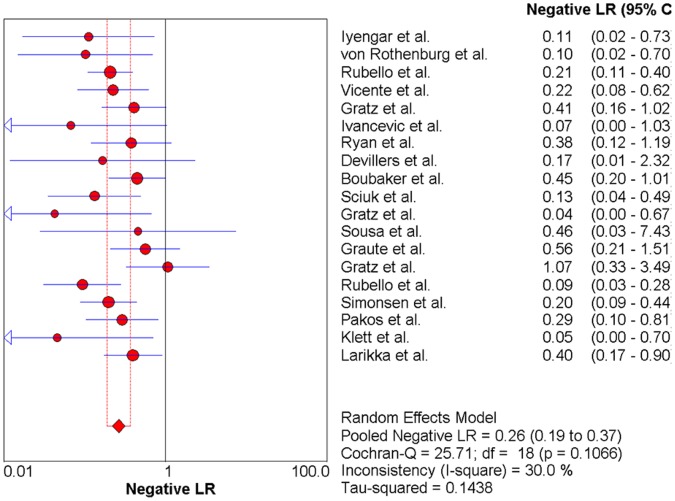
Forest plot for the negative likelihood ratio (NLR) of anti-granulocyte scintigraphy with 99mTc-monoclonal antibodies to diagnose periprosthetic joint infections (PJI).NLR (negative likelihood ratio)  =  0.26 (95% CI, 0.19-0.37).